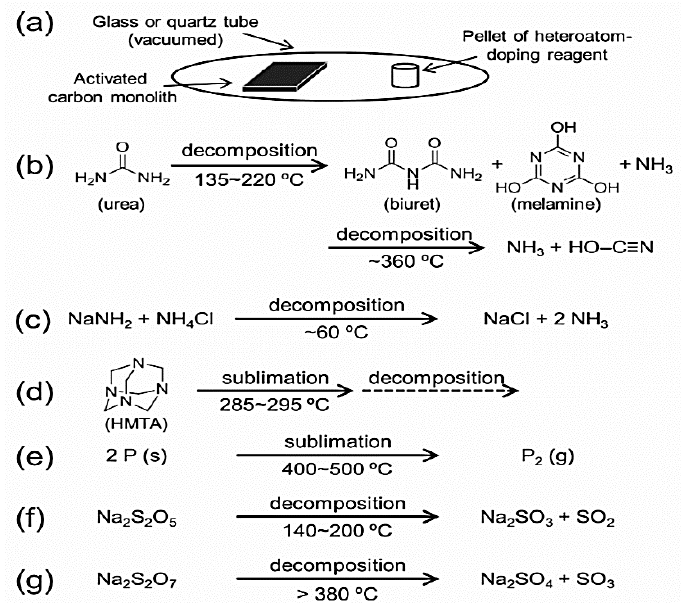
Figure 6. ( a ) Scheme illustrating hetero atom doping of carbons. ( b – g ) Reactions of the hetero-atom doping reagents at ambient pressure and high temperatures; ( b ) urea, ( c ) NaNH 2 /NH 4 Cl mixture, ( d ) HMTA, ( e ) red phosphorus, ( f ) Na 2 S 2 O 5 and ( g ) Na 2 S 2 O 7. Reproduced with permission from [74]. Copyright (2015) American Chemical Society.